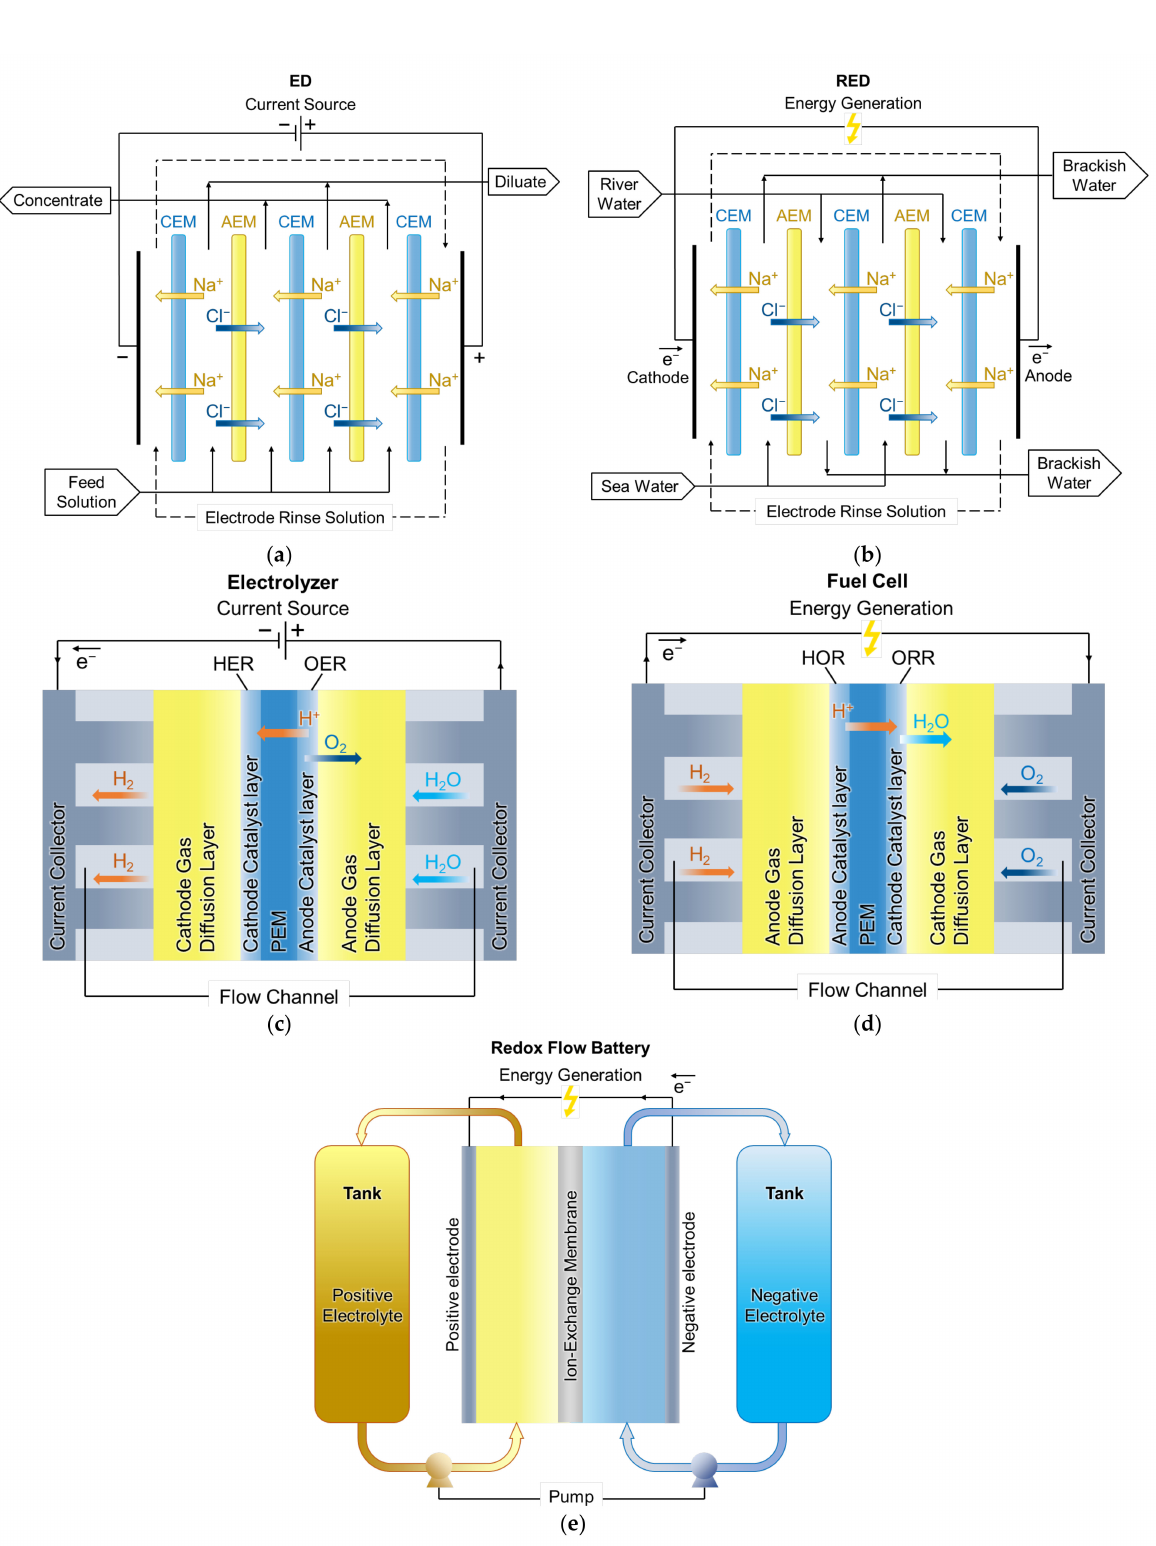
Figure 1. Scheme and principle of operation of the main membrane devices related to energy production and storage: conventional electrodialysis ( a ), reverse electrodialysis ( b ), PEM electrolyzer ( c ), fuel cell ( d ), and redox flow battery ( e